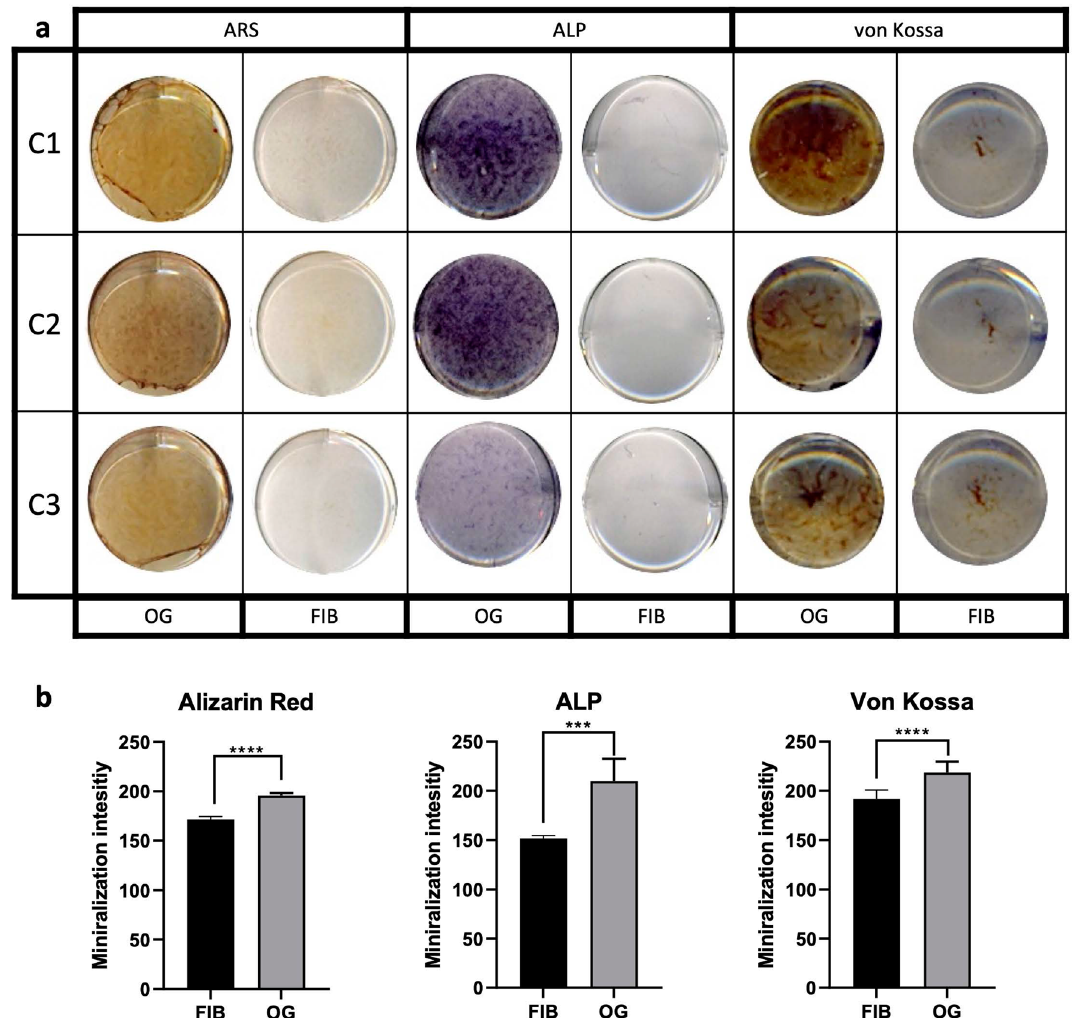
Figure 1. Functional staining for Alizarin red (ARS), Alkaline phosphatase (ALP) activity and von Kossa to show mineralization properties of transdifferentiated osteoblast-like cells from healthy donors. Primary fibroblasts from healthy donors were subjected to osteogenic transdifferentiation (OG) for 21 days; undifferentiated fibroblasts (FIB) were grown in fibroblast medium for 21 days. ( a ) Photos show representative results for 3 primary fibroblast cell cultures (C1, C2, C3). ARS and von Kossa stainings (brown) indicate calcium phosphate deposition while positive ALP staining staining (purple) shows ALP activity required for mineralization. ( b ) The intensity of the staining was quantified for ARS in 6 different primary fibroblast cell culturess, ALP and von Kossa in 9 different primary fibroblast cell cultures. Bars indicate the mean of the staining and error bars the standard deviation. Asterisks *** indicate p < 0.005 as measured by ANOVA. ( c ) Microscopic images of 3 fibroblast controls (C1, C2, C3) in the different media after 21 days of culture. ( d ) Magnified images of the mineralized nodules of osteoblast-like cells shown by Alizarin red staining. Black scale bar represents 200 µm while white scale bar represents 50